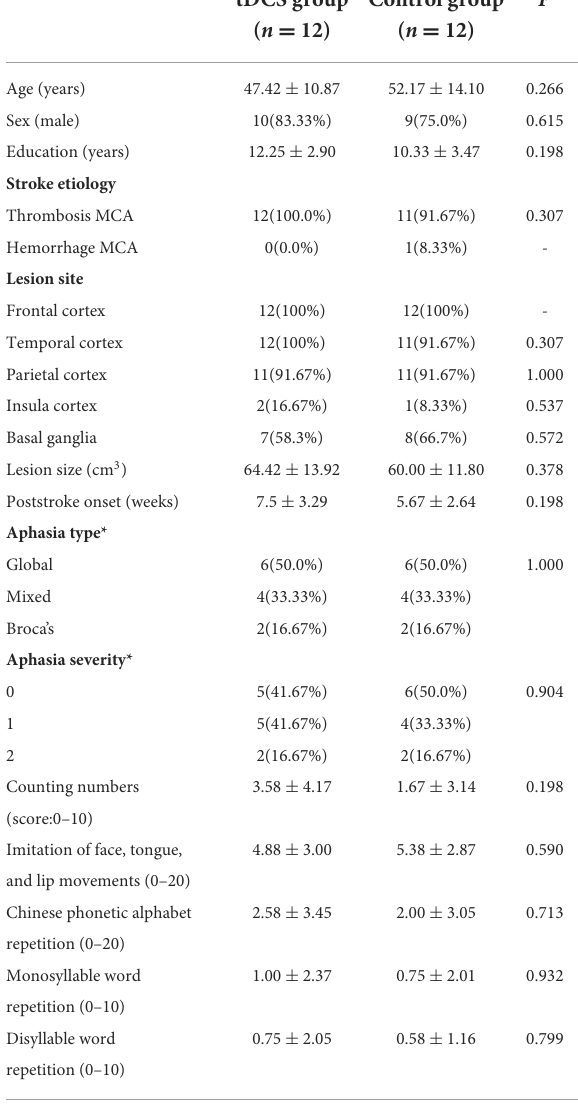
TABLE 1 Clinical characteristics and speech-language assessments at